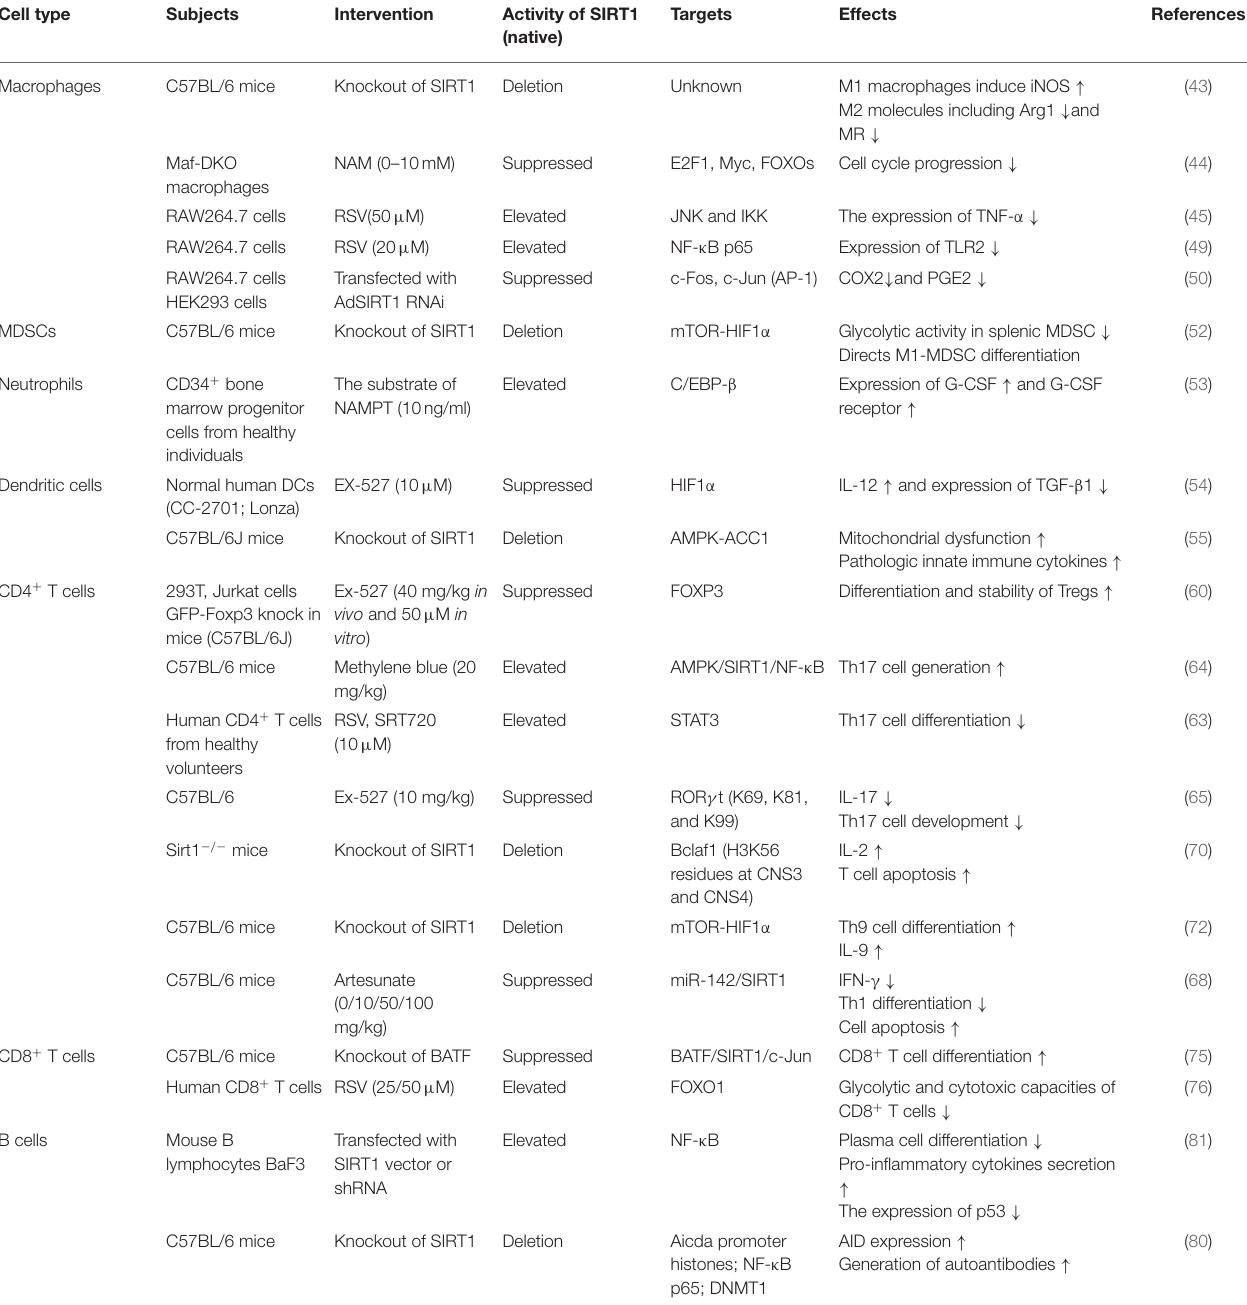
TABLE 1 | The function of SIRT1 in immune